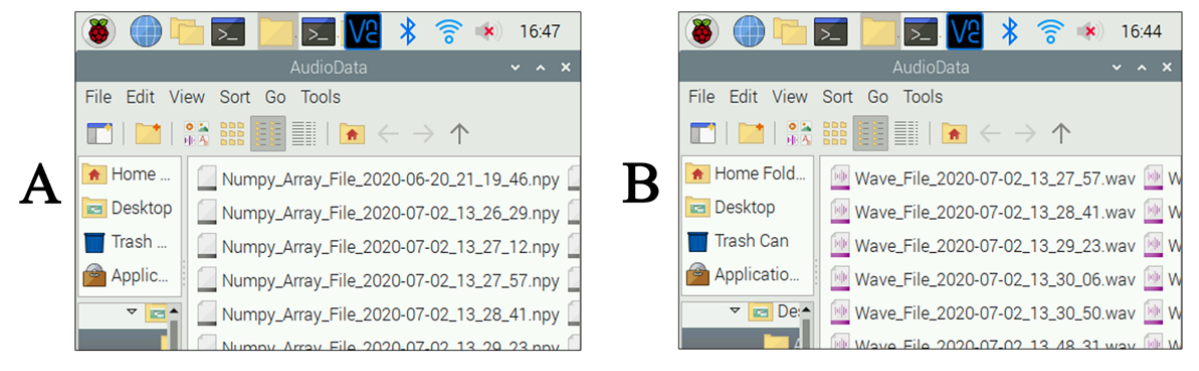
Figure 5. (A) Digital NumPy files (.npy) and (B) Waveform Audio File Format files (.wav) generated by Auscul Pi. The file names indicate the date and time of each